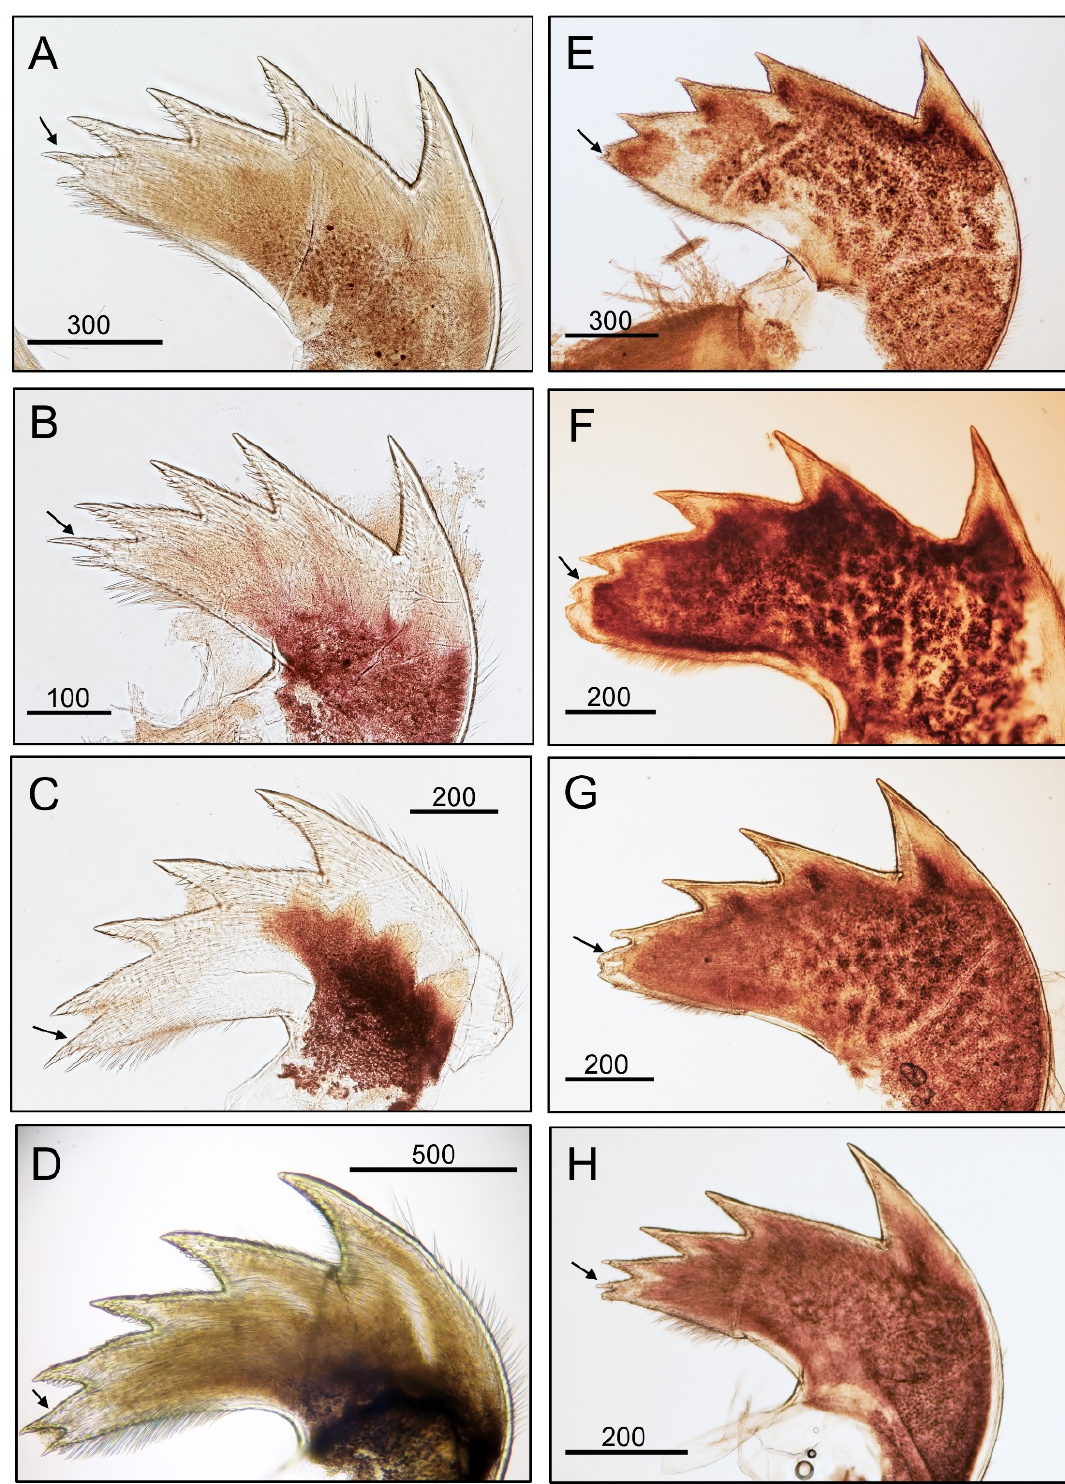
Figure 12. Comparison of mandible from four different specimens of C. virgatum ( A – D ) and four different specimens of C. hunteri ( E – H ). Note consistent differences in the size of 5th tooth (indicated by arrows) between C. virgatum and C. hunteri . Scale bars in μ m.